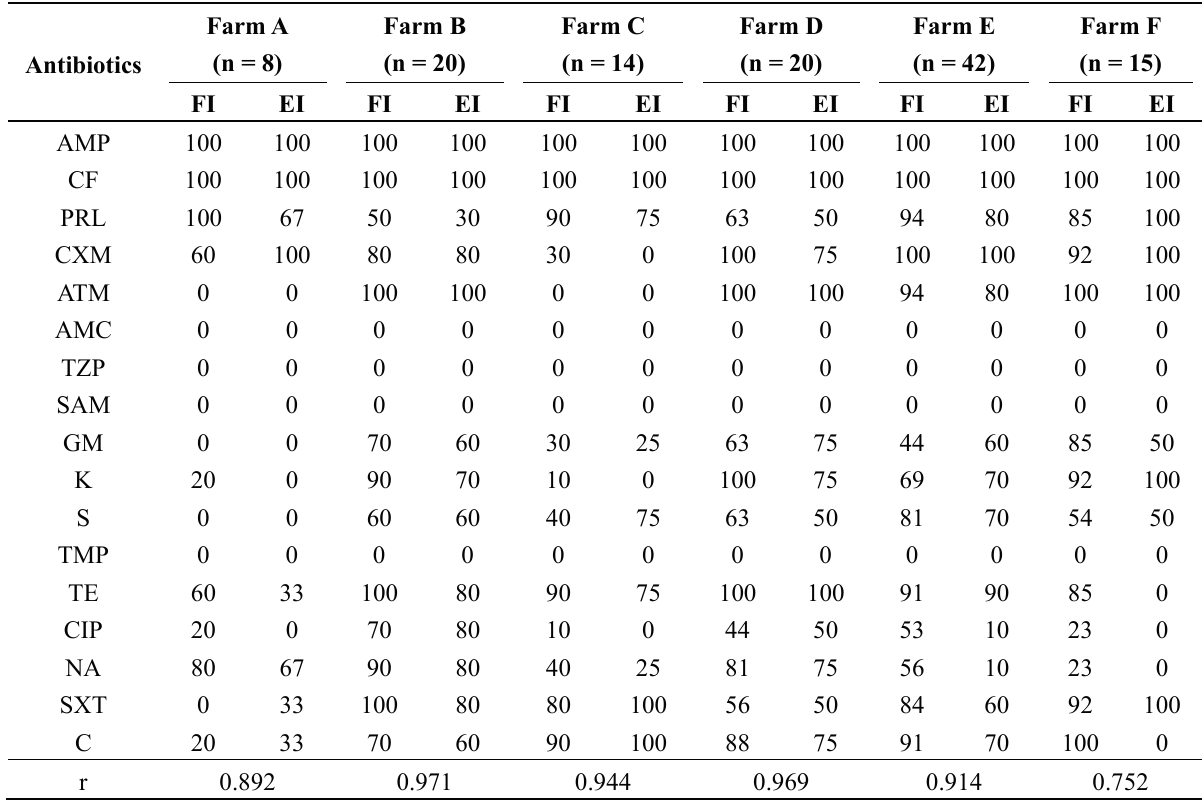
Table 3. Resistance to 17 antibiotics of the 119 ESBL-producing E. coli isolates.